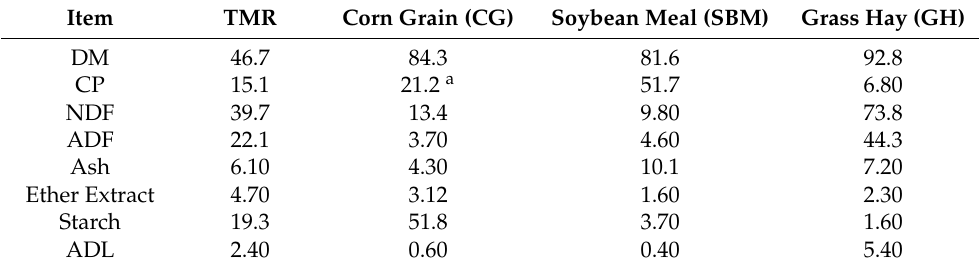
Table 2. Chemical composition of TMR, CG, SBM, and GH feedstuffs (%, DM basis). Item TMR Corn Grain (CG) Soybean Meal (SBM) Grass Hay (GH) DM